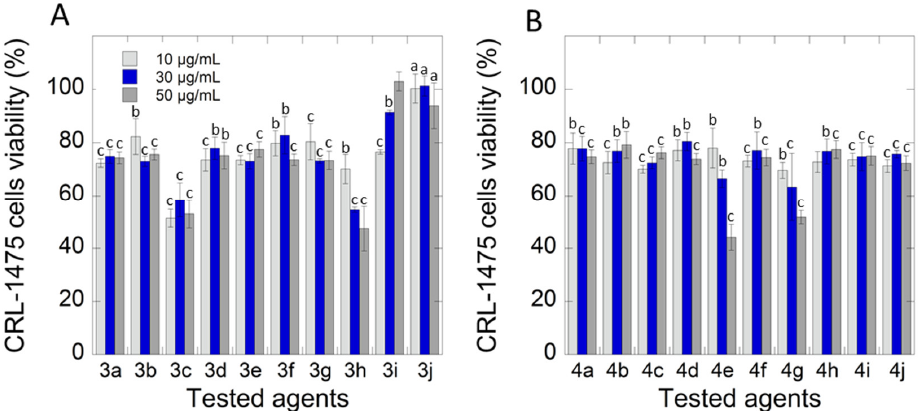
Figure 6. Viability of fibroblast CRL-1475 cells treated by synthesized salts 3a – j ( A ) and 4a – j ( B ) at concentration 10–50 µg/mL. The results are presented as the mean values + SD. a p < 0.05, b p < 0.01, c p < 0.001 compared to the control.